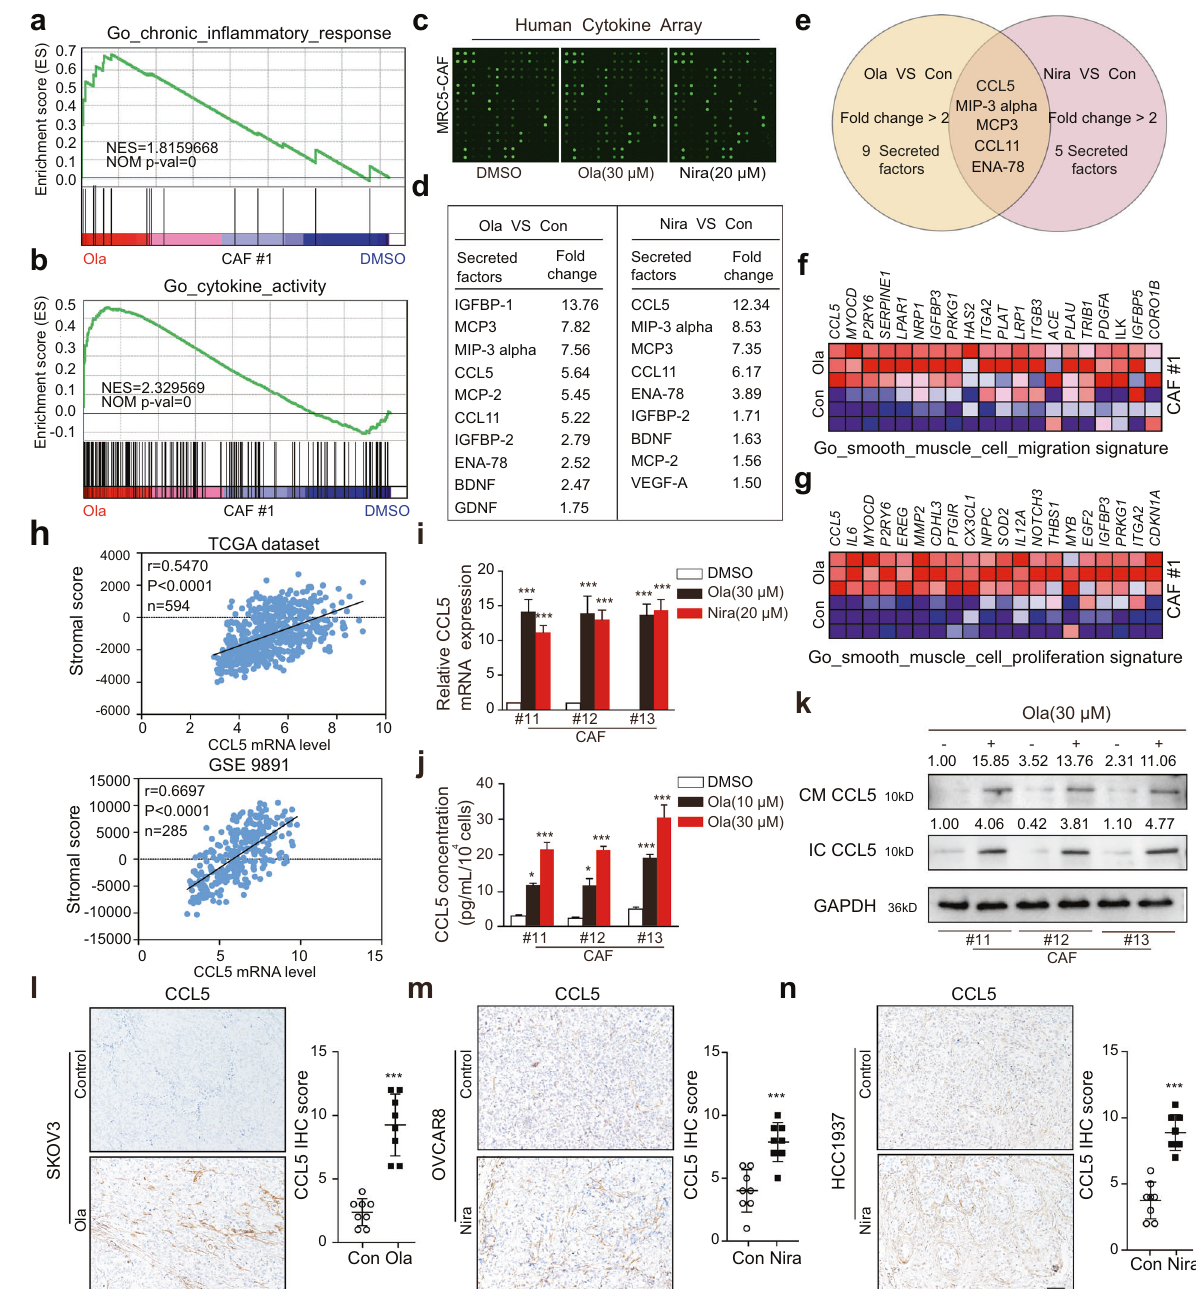
Fig. 4 CCL5 secretion increases upon PARPi stimulation and correlates with stromal activation. a , b GSEA showing signi fi cant enrichment of the in fl ammatory response and cytokine activity signature in the Ola-treated CAFs. c , d Cytokine pro fi les from control MRC5-CAFs and MRC5-CAFs primed with either 30 μ M Ola or 20 μ M Nira for 72 h. The obviously elevated cytokines in the CM of MRC5-CAFs treated with Ola or Nira are listed. e Overlapping cytokines in the CM samples of MRC5-CAFs treated with Ola and Nira. f , g GSEA-derived heatmap showing the relative mRNA expression levels of smooth muscle cell activation-regulated genes in Ola-treated CAFs. h Spearman ’ s correlation analysis showing the relationship between CCL5 expression and the calculated stromal component score in the TCGA dataset, GSE 9891. i CCL5 mRNA expression by qRT-PCR in primary CAFs with or without PARPi treatment. j ELISA of CCL5 secreted by primary CAFs with or without PARPi exposure. k Immunoblotting of CCL5 protein in primary CAF extracellular conditioned medium (CM) or in cell lysates (IC) after PARPi exposure. GAPDH served as the loading control. Relative densitometric values are labeled in the photographs. l – n Representative IHC images and quanti fi cation of CCL5 protein expression in the Ola or Nira-challenged and control xenograft tumor stroma. Measurements were taken from distinct samples ( n = 8). Scale bar, 50 µm. Data are expressed as mean ± s.e.m., * p < 0.05; ** p < 0.01; *** p < α -SMA expression, and p-NF- κ B expression was positively stroma accumulation (Fig. 7c – e). Further IHC analysis showed correlated with CCL5 expression (Fig. 7h, i). Collectively, the above higher expression of CCL5 and p-NF- κ B in tumor specimens after results suggested that PARPi promoted stromal fi broblast activa- PARPi therapy (Fig. 7f, g). Furthermore, correlation analysis of IHC tion in human OC tumor specimens. score showed that CCL5 expression was positively correlated with